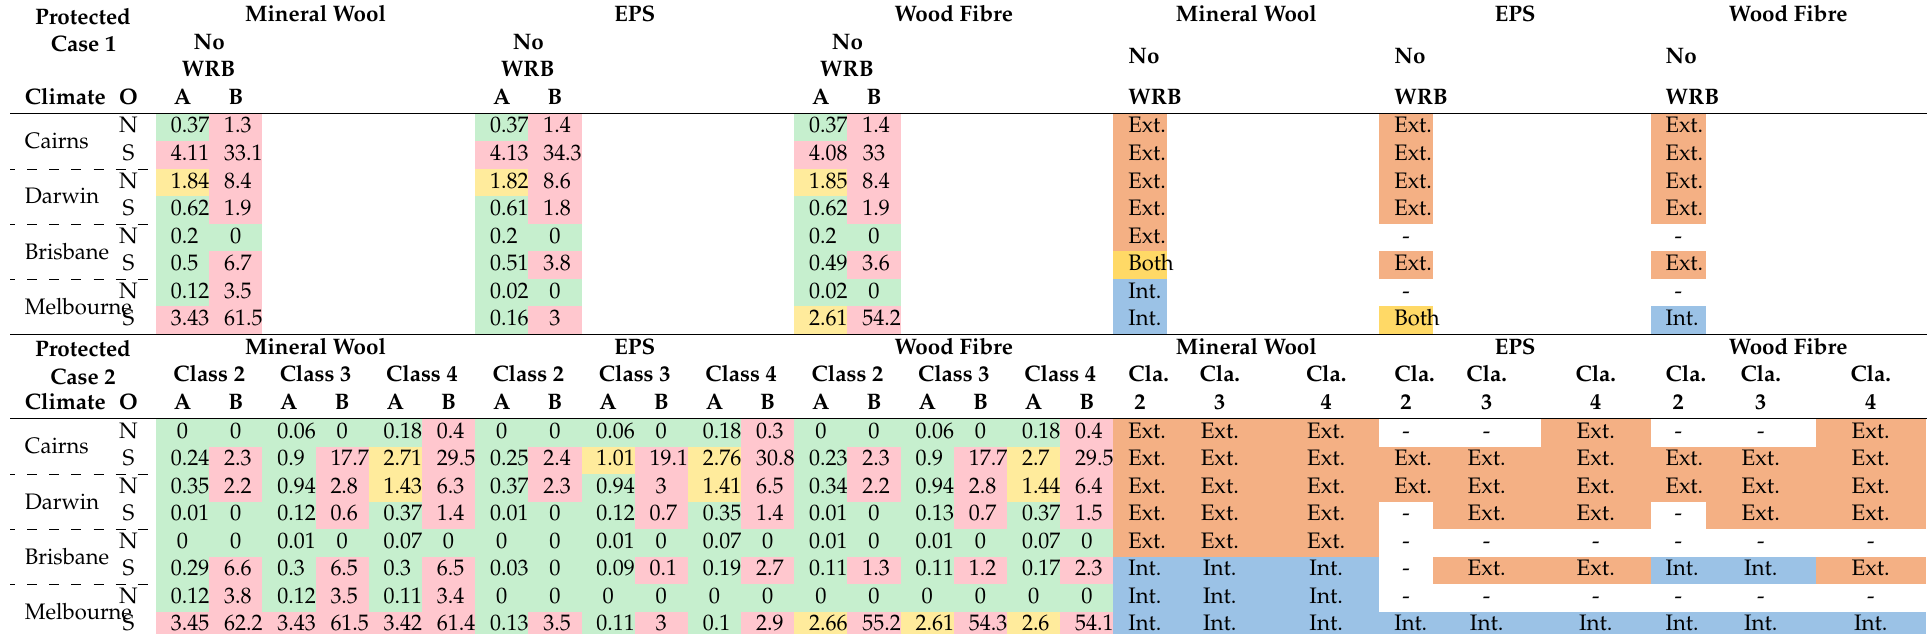
Table A3. Protected CLT results for internal insulation. O (orientation). Performance criteria: A (mould growth index), B (corrosion rate). Classification of WRB: Class 2, 3, and 4 (vapour permeance). Green (pass), red (fail), or yellow (further investigation). Critical surface that fails the performance criteria indicated in right table: Ext. (external surface), Int. (internal surface), Both (both